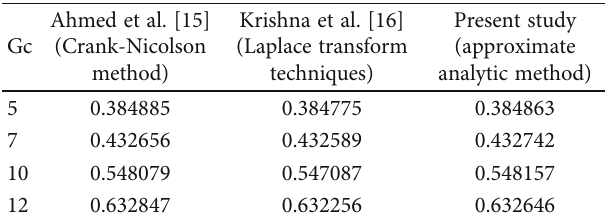
Table 5: Comparison of results of velocity, M = 0 : 5 , Sc = 0 : 22 , k = 0 : 5 , Pr = 0 : 71 , F = 1 , Gr = 5 , t = 1 , Ec = 0 : 3 , F = 0 : 5 , H = 1 , m = 1 , λ = 0 : 5 , ω = 0 , and y = 2 .